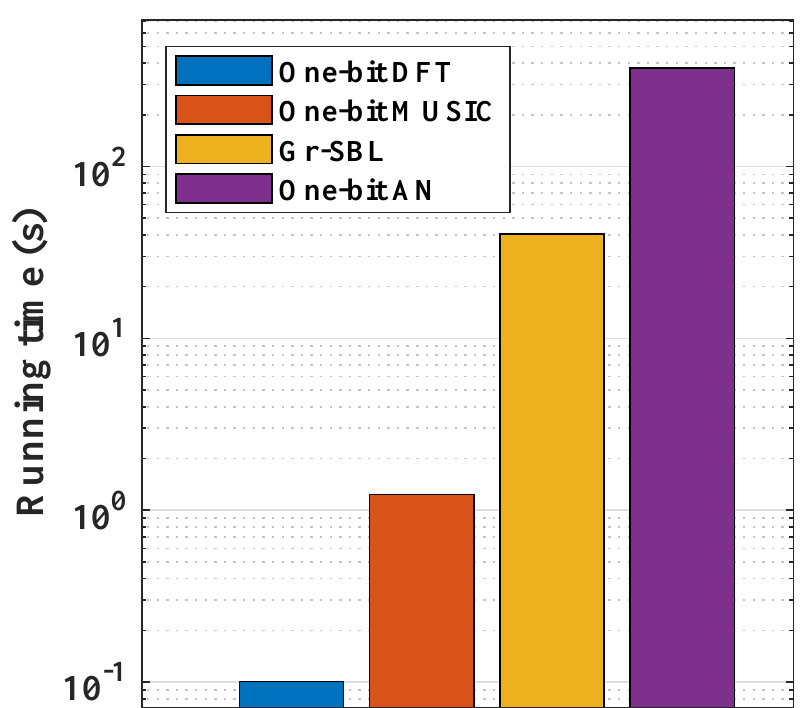
Figure 5. MAE versus SNR.